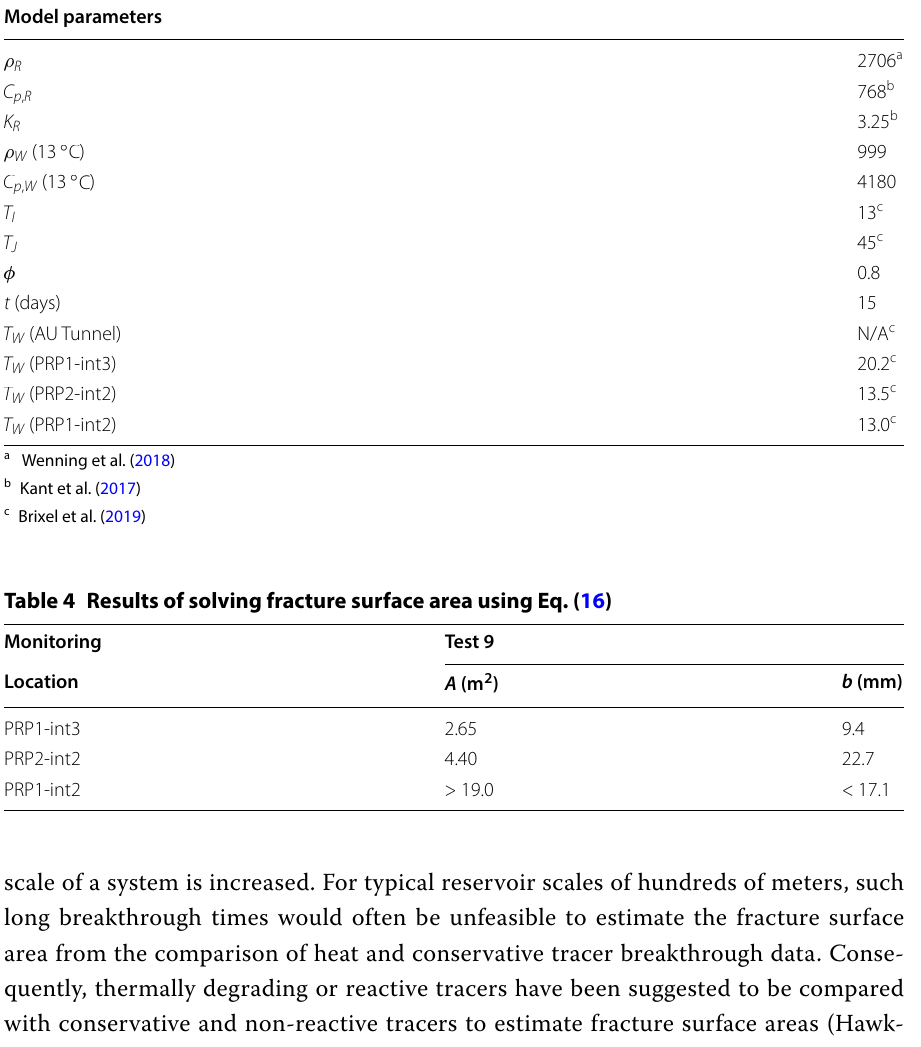
Table 3 Summary of thermal and petrophysical properties used